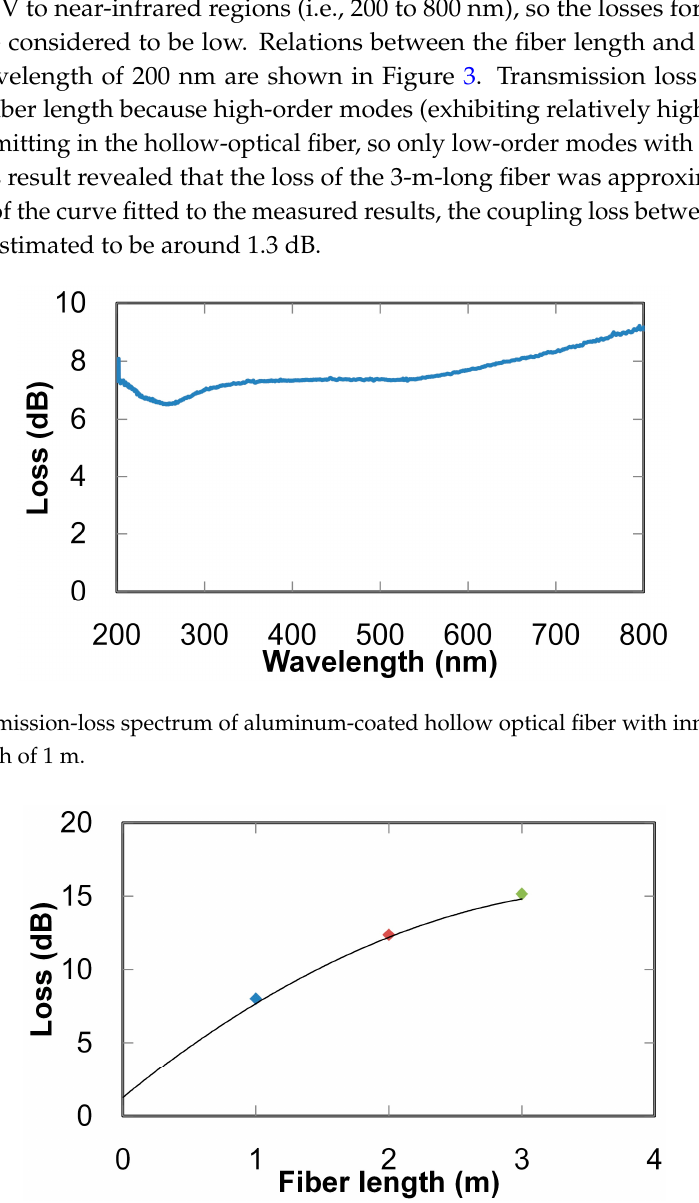
Figure 3. Transmission losses of aluminum hollow optical fiber with different lengths measured at wavelength of 200 nm.